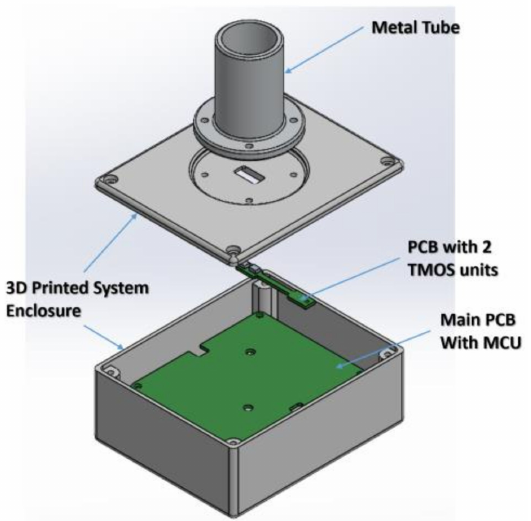
Figure 6. The schematics of the packaged radiometer, with a tube that limits the Field of